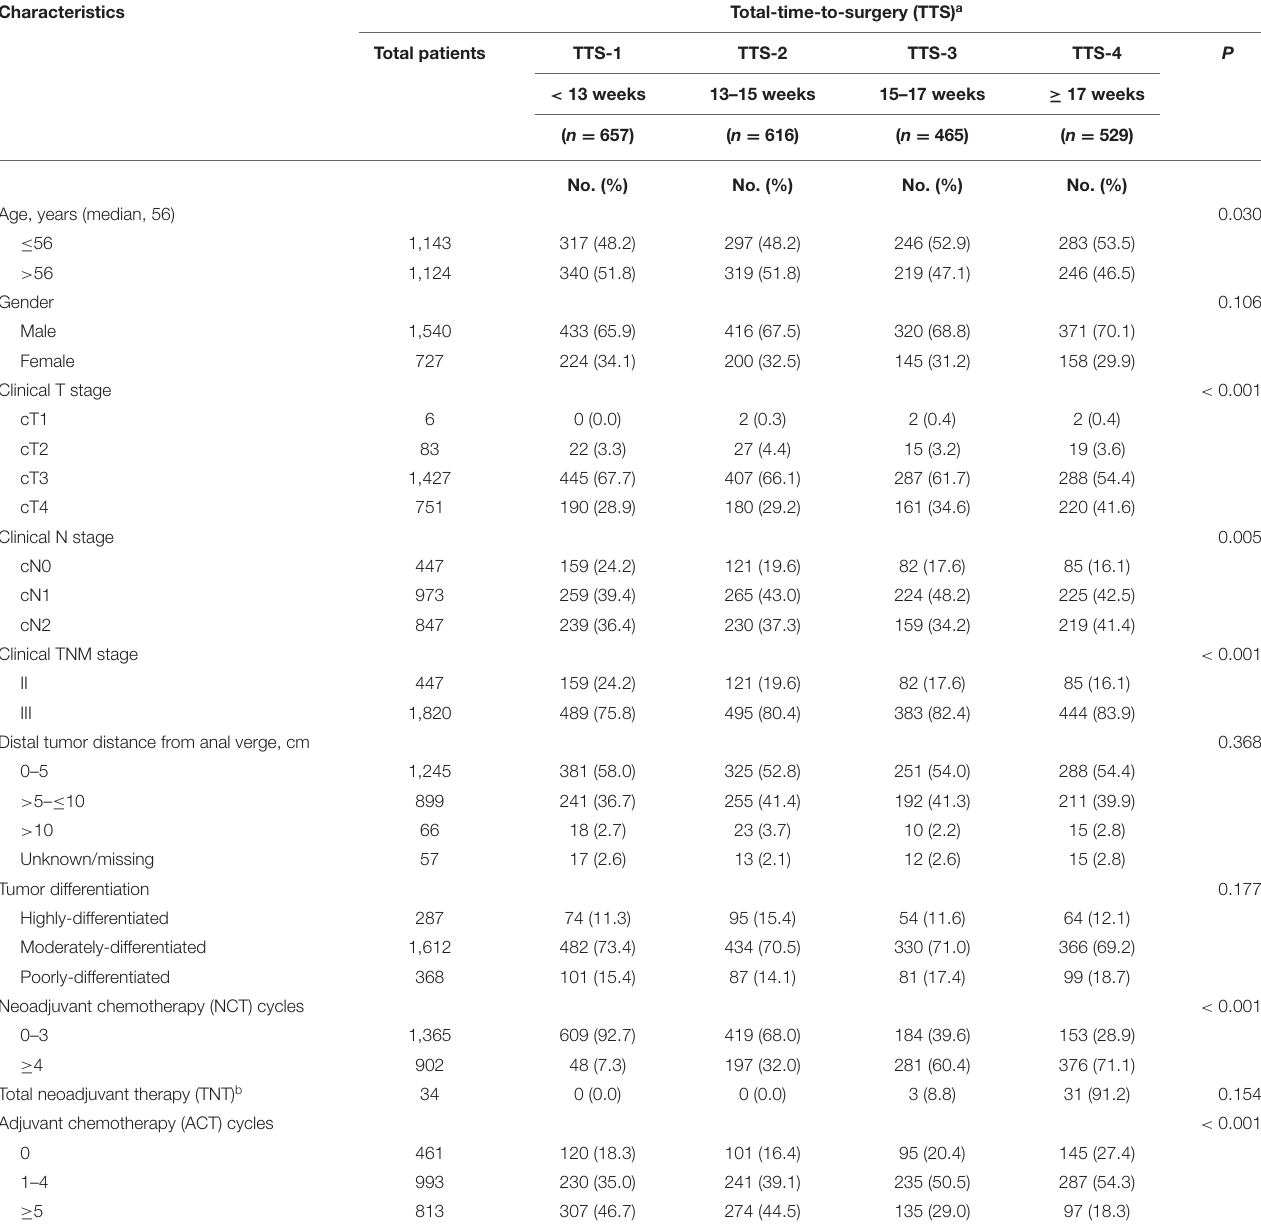
TABLE 1 | Demographic and clinicopathological characteristics, by total-time-to-surgery (TTS) a , of 2,267 patients with locally advanced rectal cancer, January 2010 through December 2018.